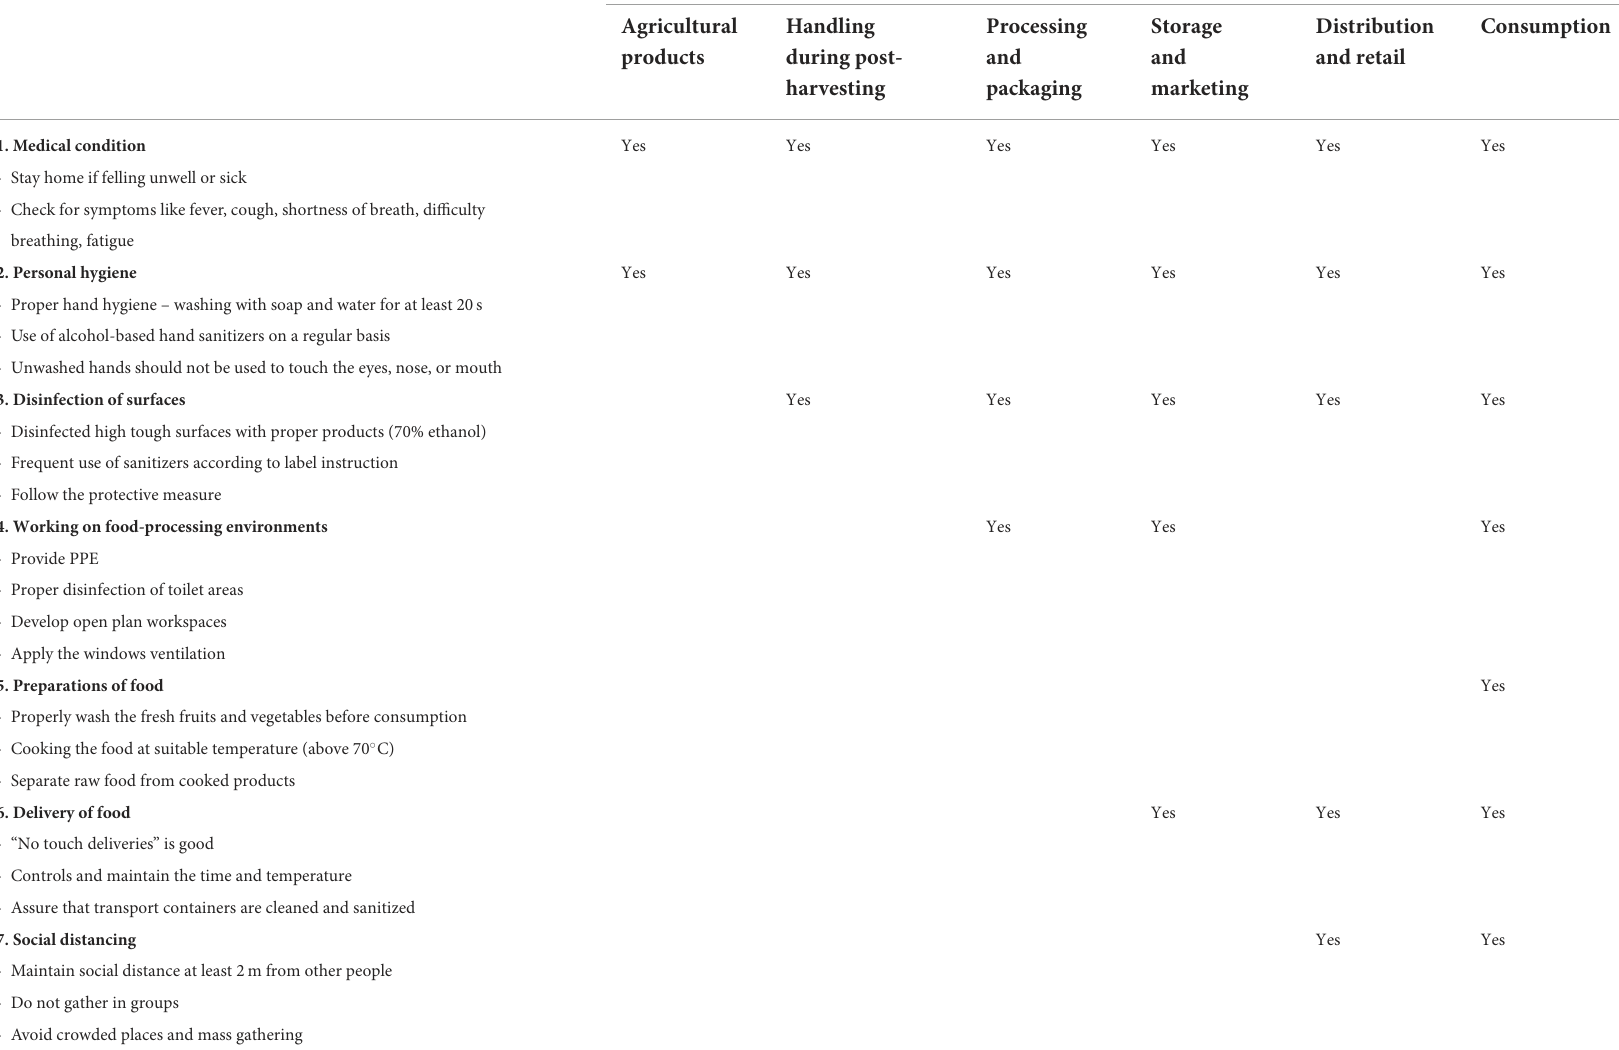
TABLE 1 Food safety guidelines of the food chain during COVID-19